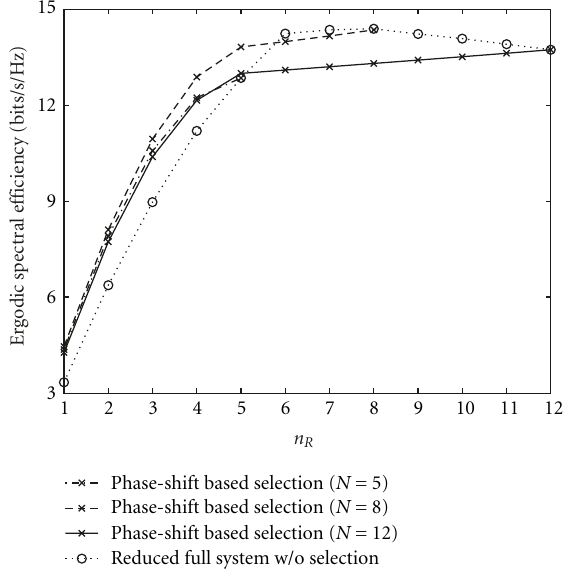
Figure 9: Ergodic spectral e ffi ciency of a compact MIMO system with the phase-shift-based selection, where M =